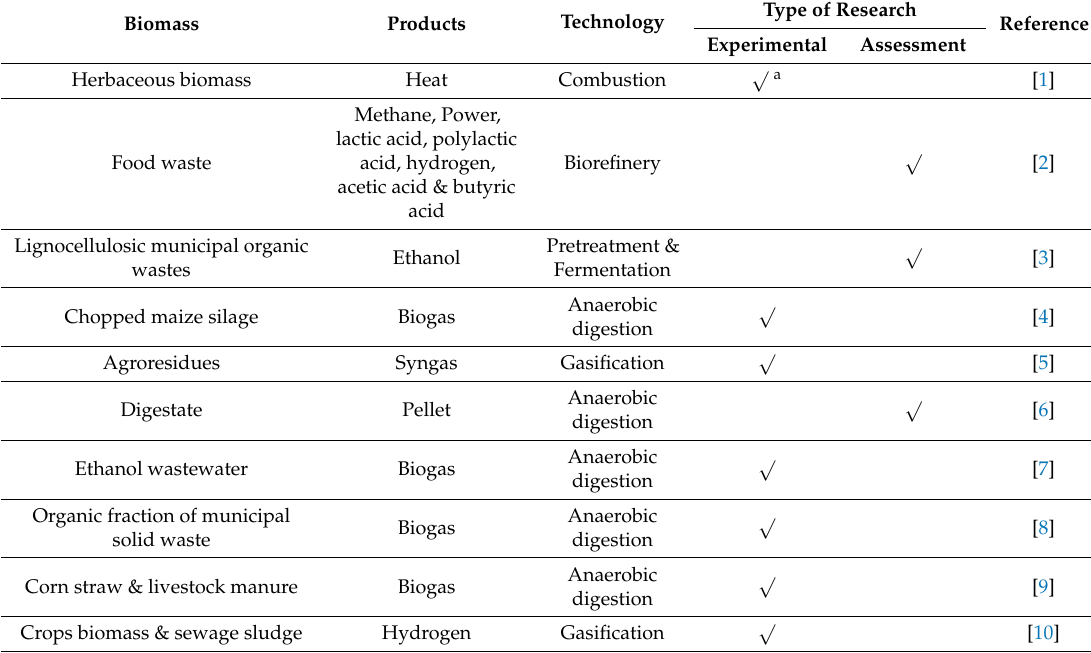
Table 1. Brief summary of the key information from the submissions to this Special